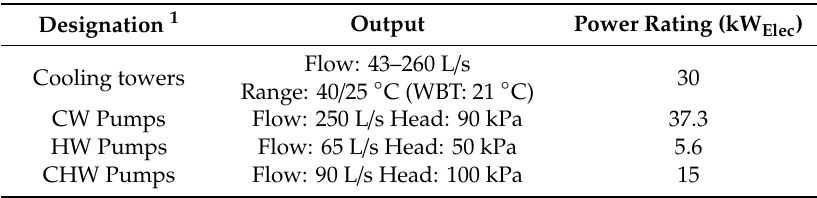
Table 5. Technical specification of other components in the chilled water